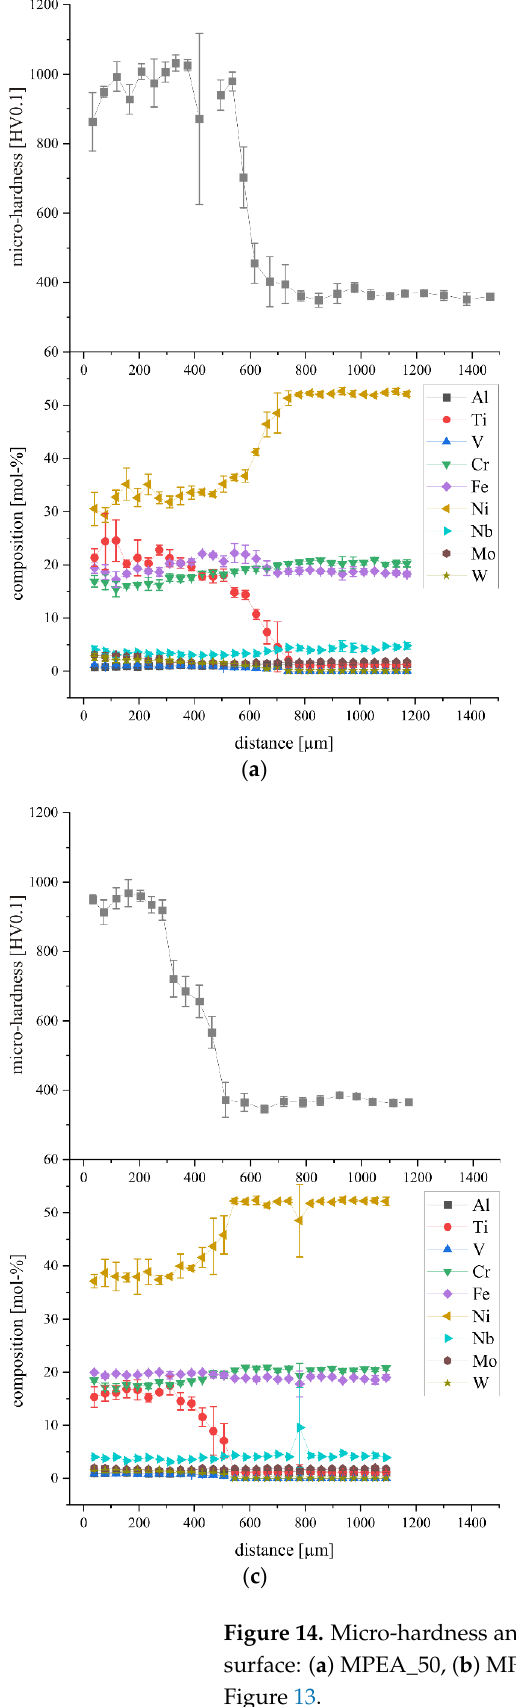
Figure 13. Exemplary hardness imprints ( left ) and measurement points of the EDS ‐ line scan ( right ). The measurement series started close to the top surface of the samples and continued along a straight line parallel to the PBF ‐ LB built direction (z ‐ axis) to the substrate plate.